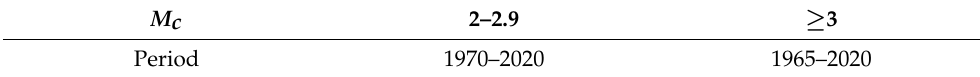
Table 2. Periods of completeness in function of magnitude for the instrumental catalogue.